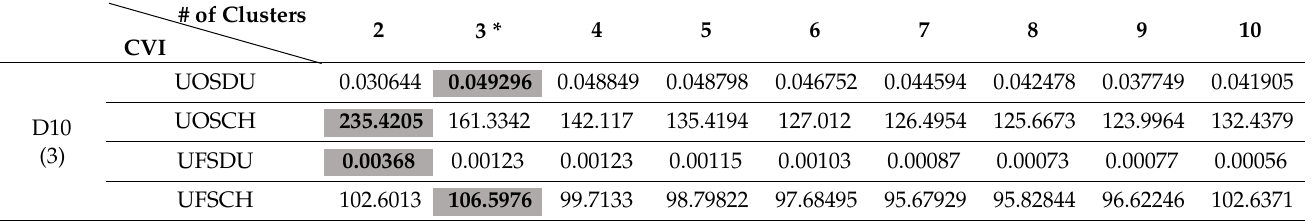
Table 11. Performance results for D10.